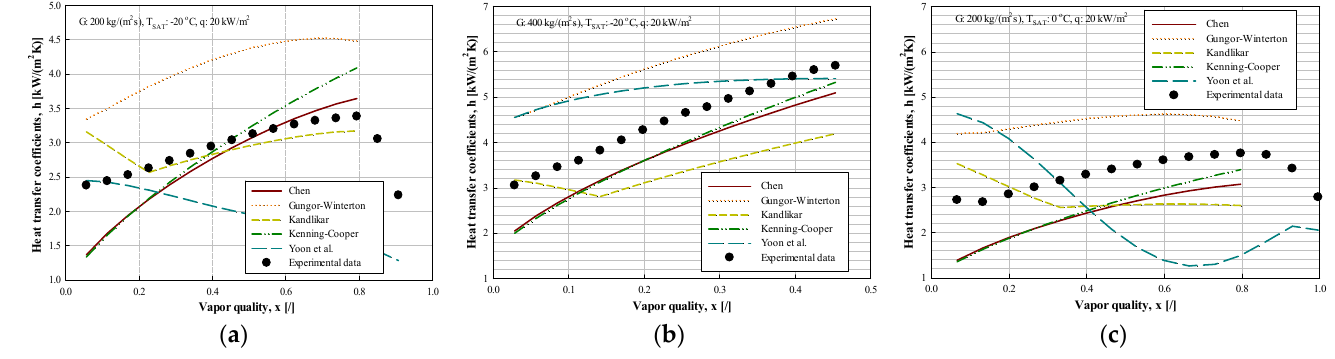
Figure 10. Comparison of the heat transfer coefficient calculated using existing correlation and experimental heat transfer coefficient according to the increase of vapor quality under each given condition ( a – c ).